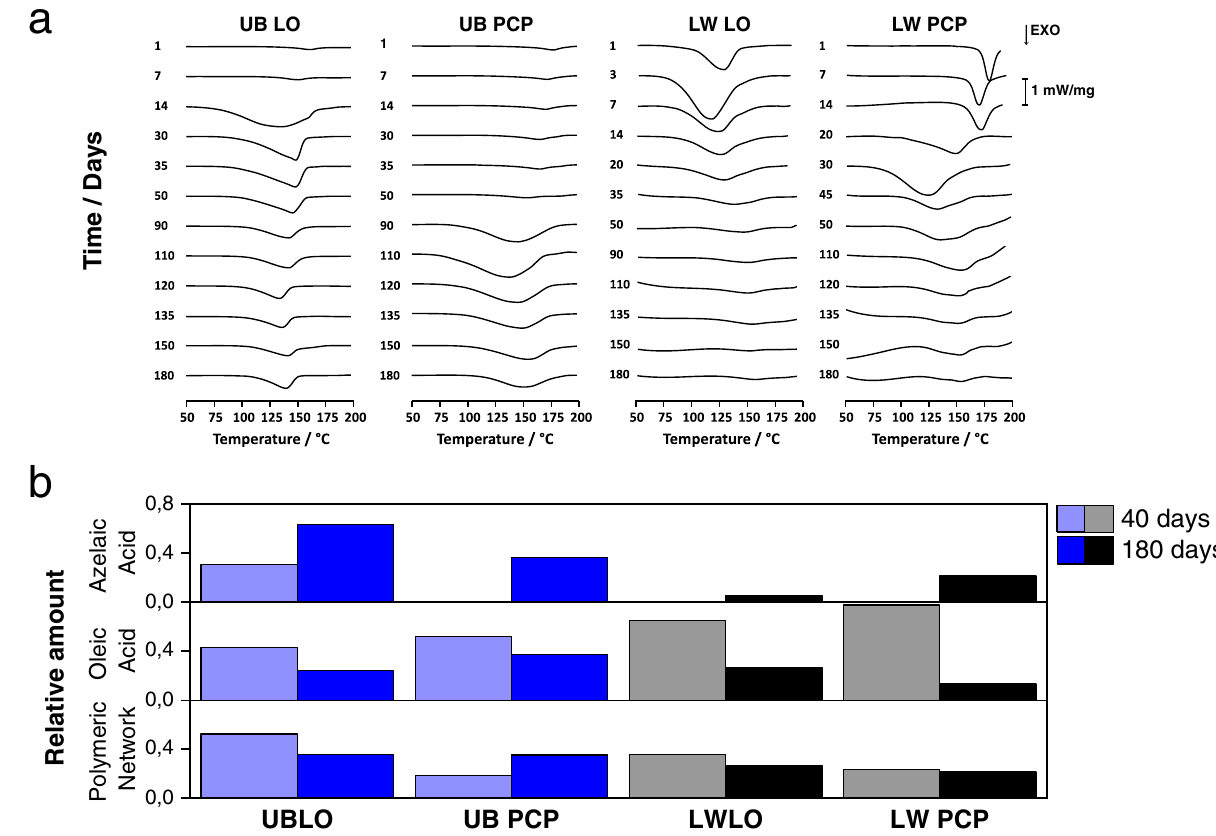
Fig. 5 | Curing of oil paint layers. DSC curves ( a ) and relative amount Py/GC/MS extracted ion pyrograms ( b ) of ultramarine blue (UB) and lead white (LW) model paints up to 180 days of natural ageing. Solids content of UB LO, UB PCP, LW LO, and LW PCP are φ =6, 33, 31, and 29vol%, respectively, including 12vol% (UB PCP) and15vol%(LWPCP)ofEY. b Theevolutionoftheoilpolymericnetwork( m / z 129),